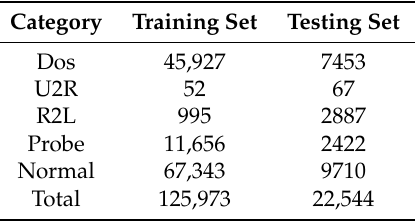
Table 2. The NSL-kdd dataset